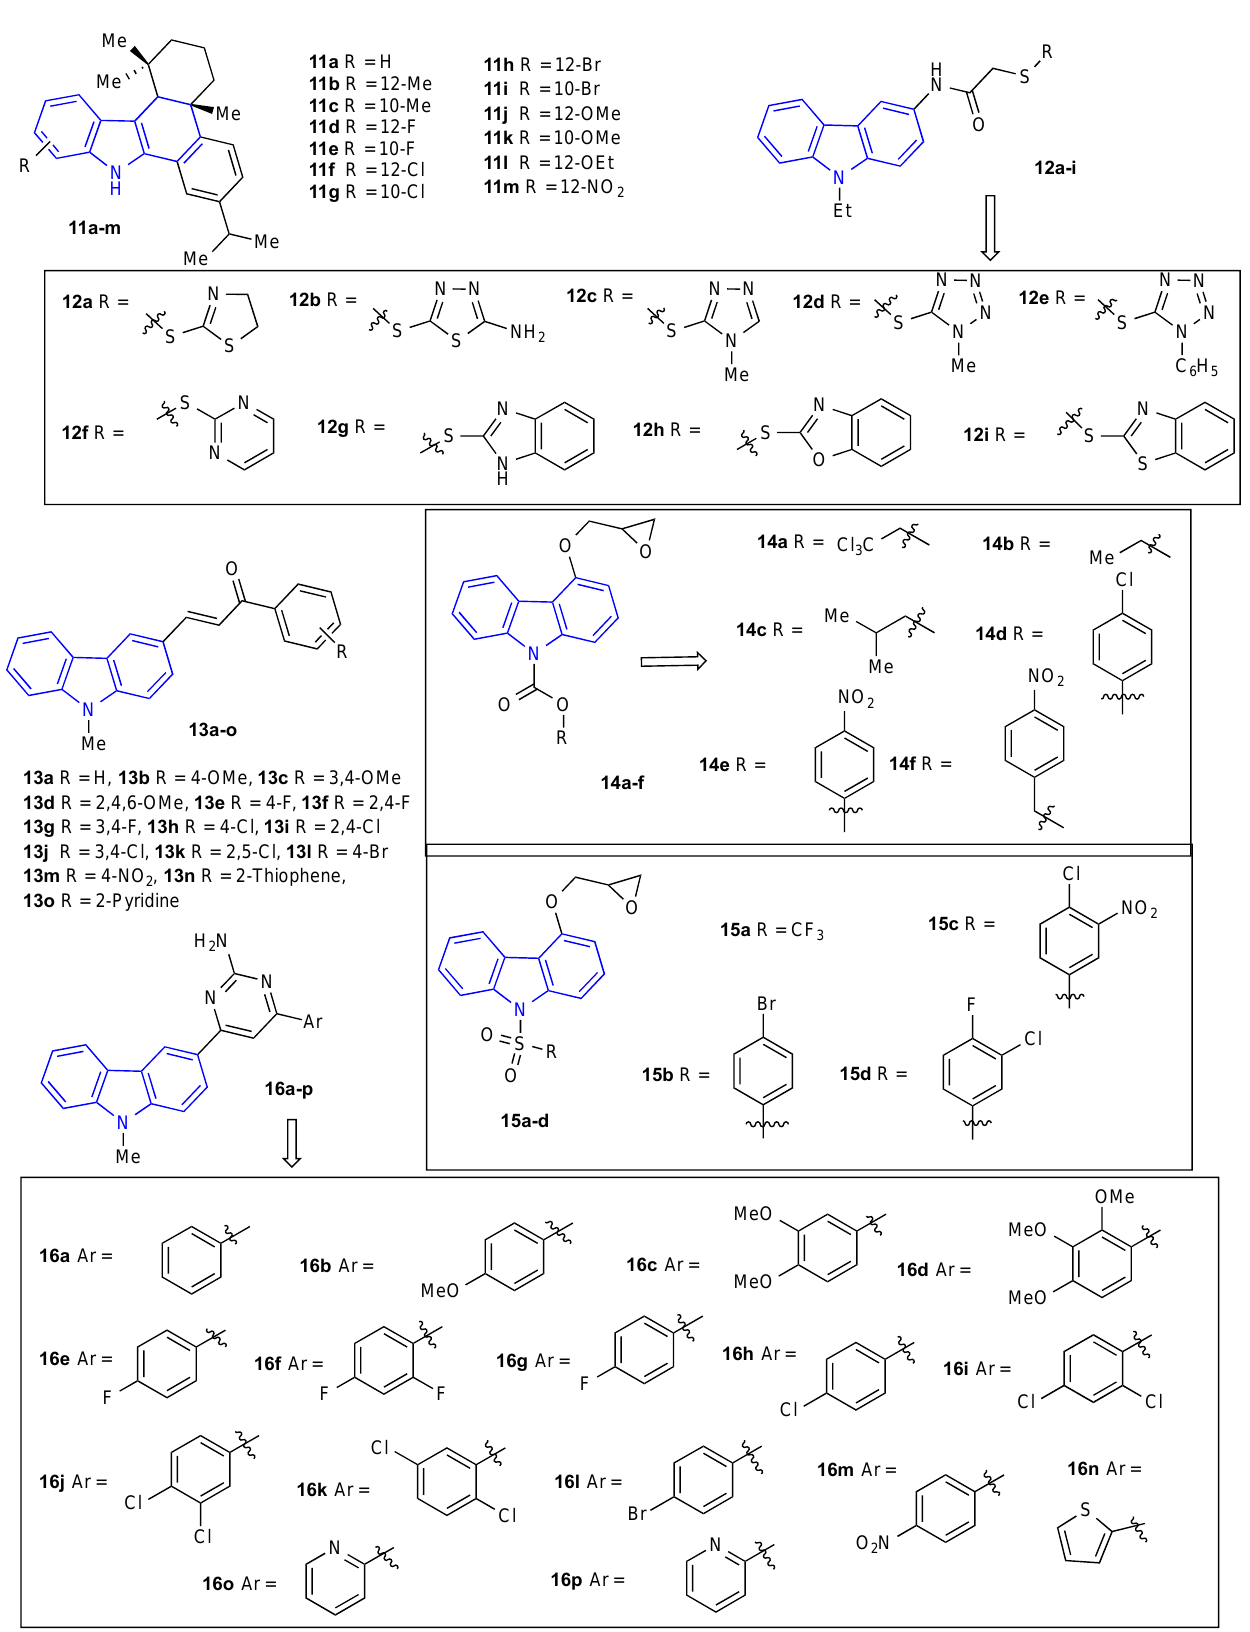
Figure 4. Structures of the reported carbazole derivatives from 2010 to 2013 .